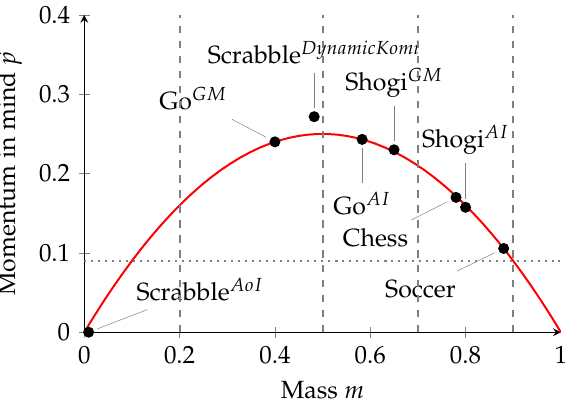
is important for maintaining fairness 2